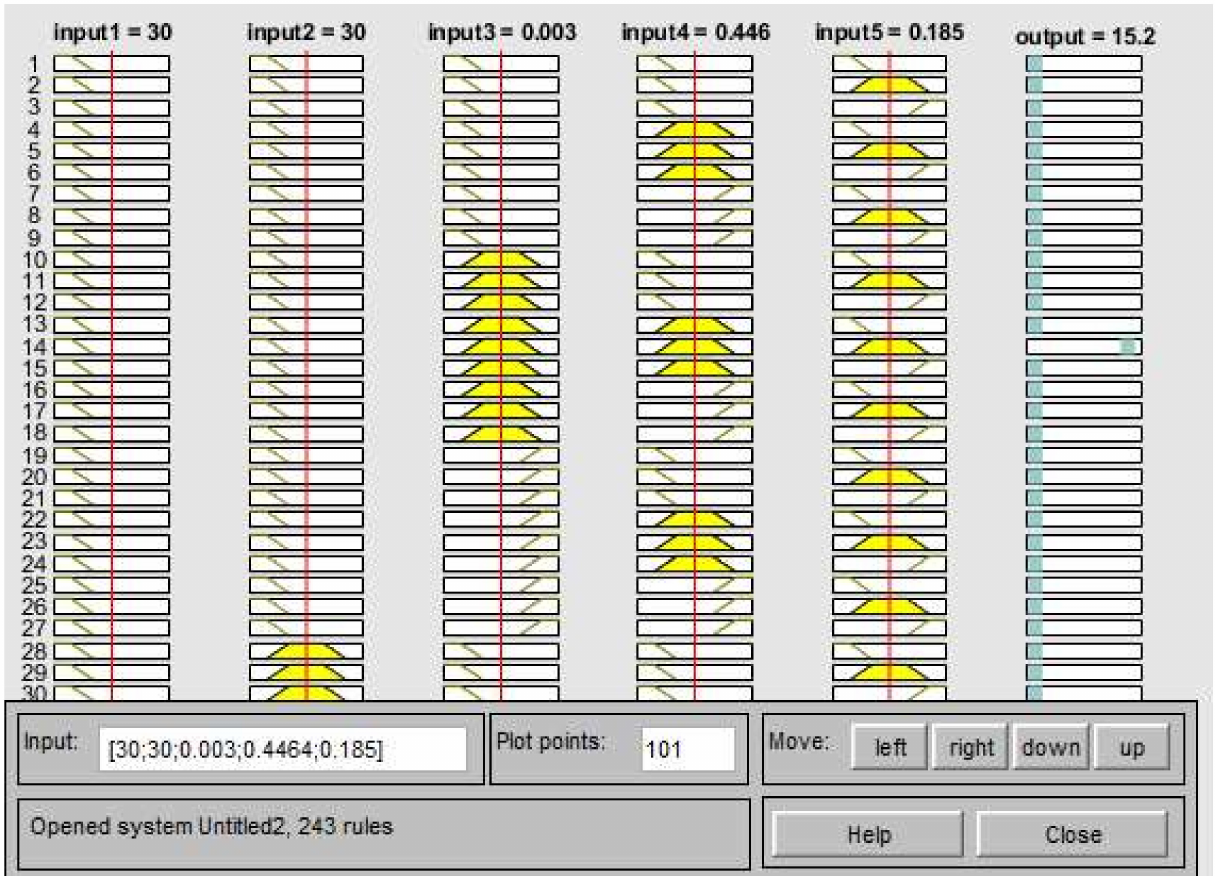
Figure 9. Representation of rules for the generated FIS.